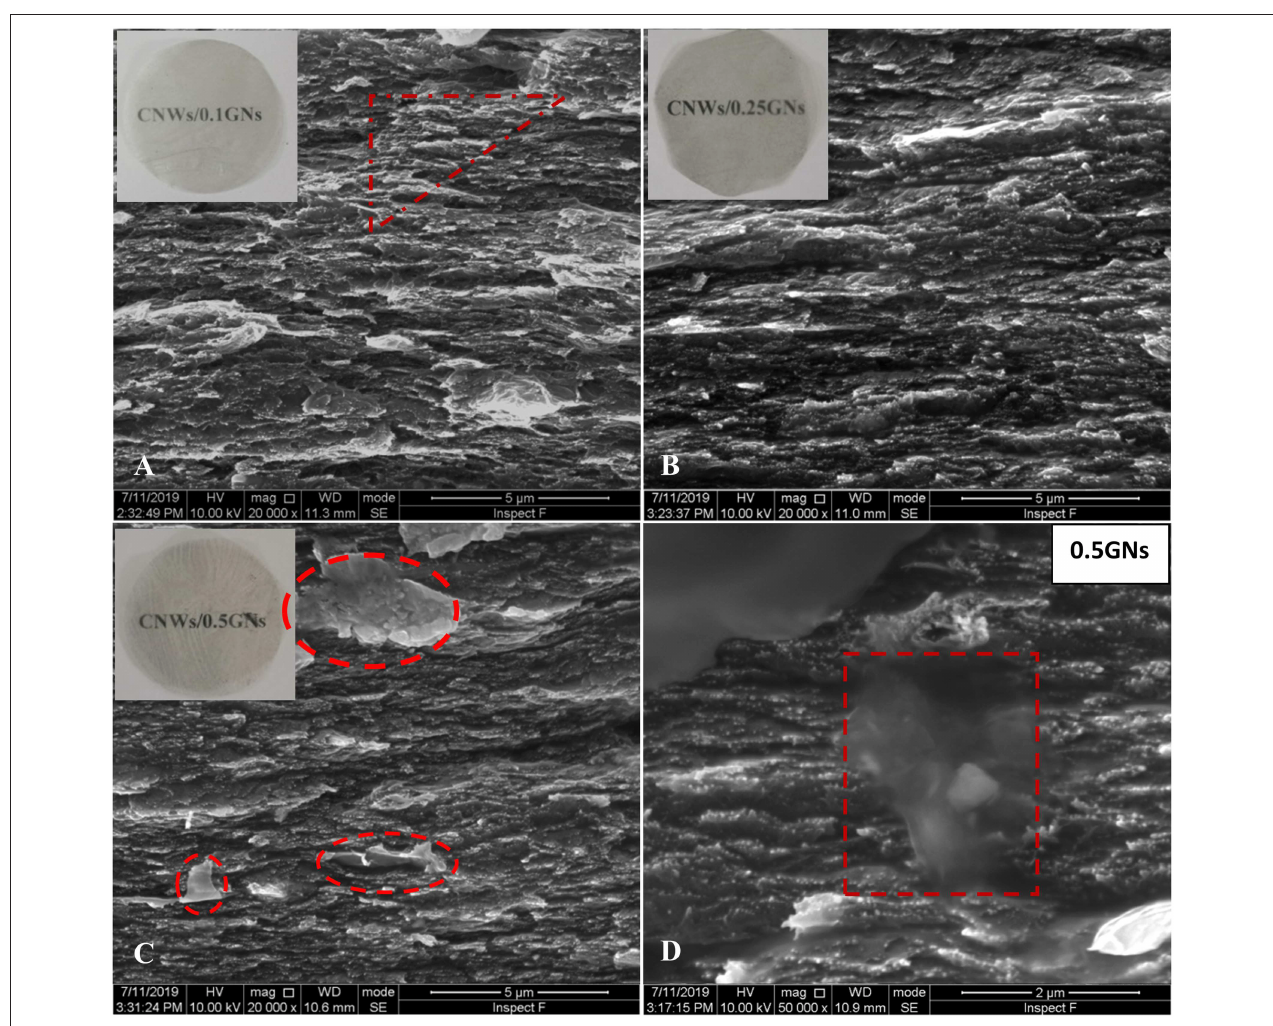
FIGURE 2 | Cross sectional SEM images of CNW/GN composite films at different GN contents: (A) 0.1 wt%, (B) 0.25 wt%, (C) 0.5 wt%, and (D) 0.5 wt% (indicating the thin GN sheets attached onto cross sectional